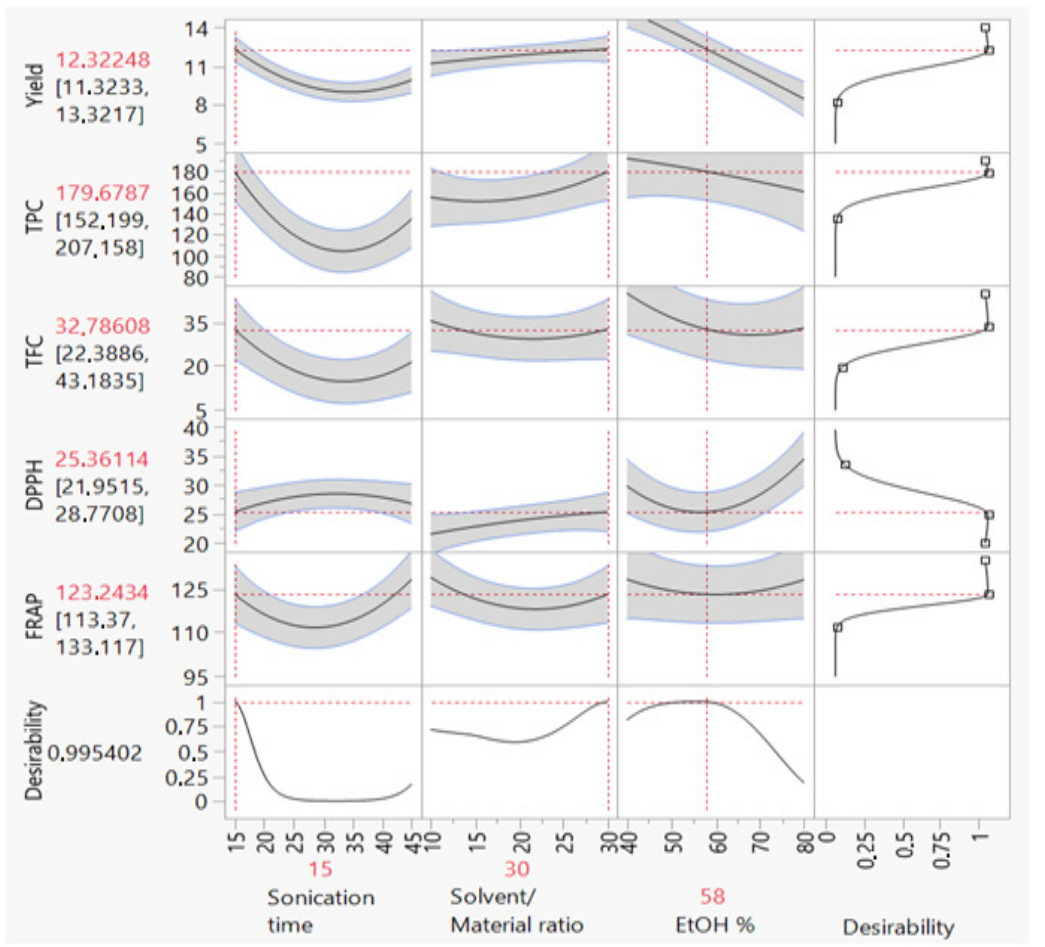
Figure 5. Desirability plots of simultaneous optimization showing the precise parameters setting leading to the optimal value for ( a ) yield, ( b ) TPC, ( c ) TFC, ( d ) DPPH-IC 50 , and ( e ) FRAP-EC 50.